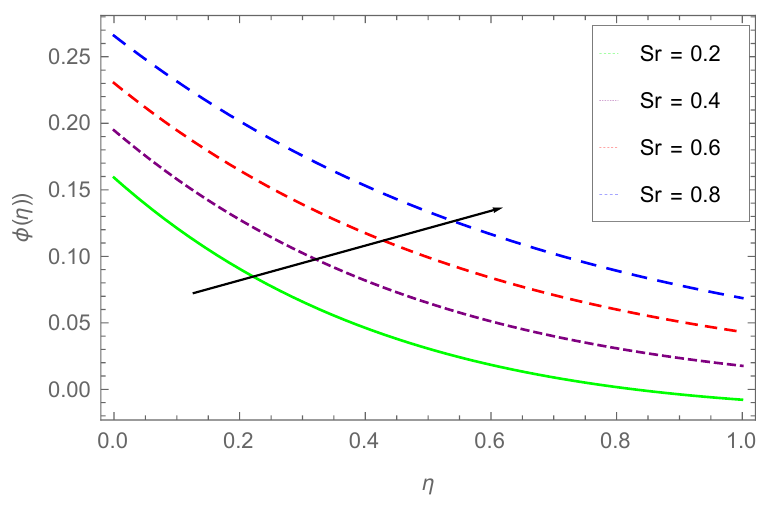
Figure 11. Dependence of φ ( η ) on Sr .